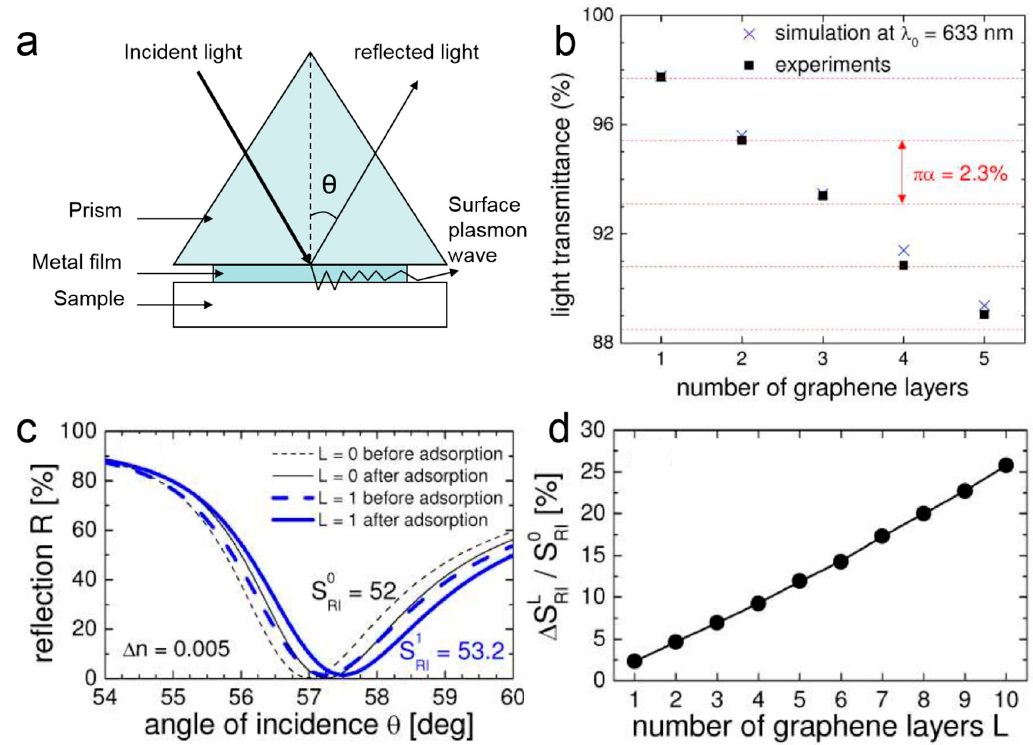
Figure 3. ( a ) The structure of surface plasmon resonance (SPR) sensor and its working principle. ( b ) Simulated transmittance of light at λ 0 = 633 nm (crosses) and measured transmittance of white light (squares) as a function of the number of graphene layers. ( c ) The SPR curves for the conventional biosensor (L = 0) and the monolayer graphene biosensor (L = 1) for He-Ne laser light. ( d ) The sensitivity enhancement ∆ S RIL / S RI0 as a function of the number of graphene layers L. Reproduced from [68] with permission of the Optical Society of America.